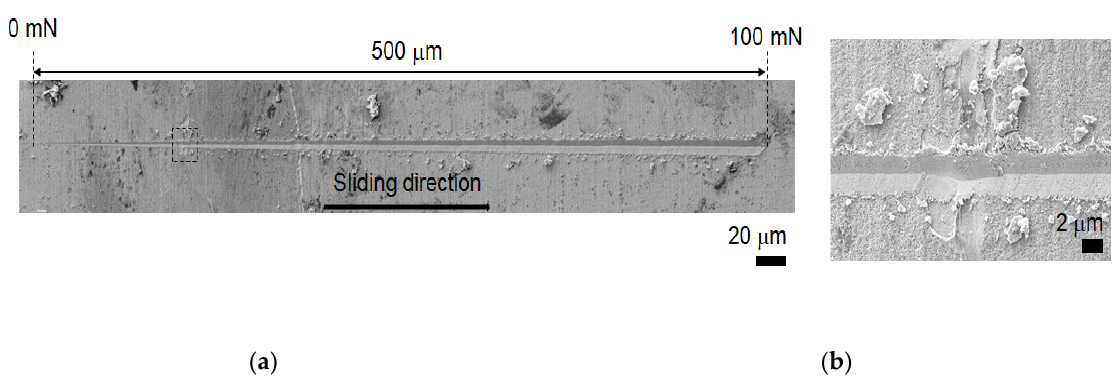
Figure 9. ( a ) Field emission scanning electron microscopy (FE-SEM) micrograph for the nanoscratch track and ( b ) magnification of the top-view (FE-SEM) image of nanoscratch tracks where the first adhesive damage appears for the reference sample.